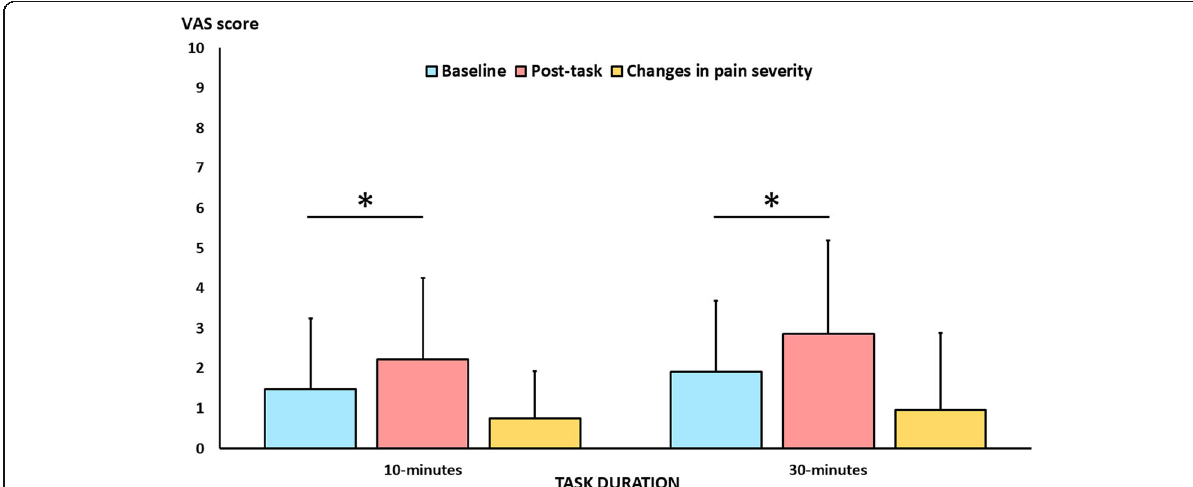
Fig. 1 Pain severity as measured by VAS. Severity is shown at baseline and after each task duration. Changes in pain severity or each tested duration is also shown. (*) indicates within task significant differences ( P <